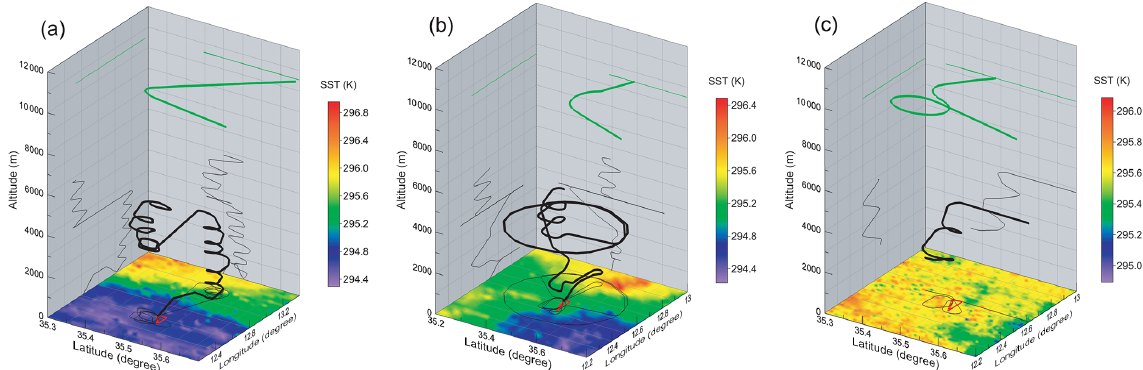
Figure 5. ATR-42 (black curve) and Falcon 20 (green curve) flight paths on (a) 22 June, (b) 28 June, and (c) 3 July, and projections on horizontal and vertical planes. The surface map of the SST from MODIS is shown with the colour scale. A schematic map of Lampedusa contour is shown in red. Please, note that the latitude–longitude and the SST scales are different in each